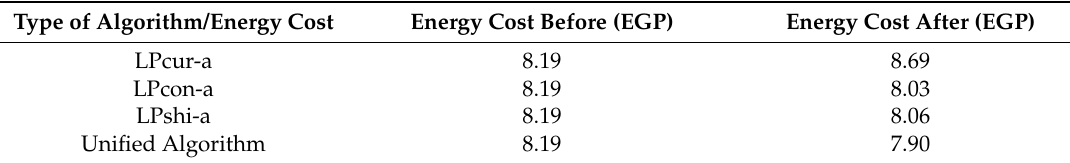
Figure 10. Room temperature variations with HEMS algorithms. Table 4. Energy Cost under HEMS algorithms.